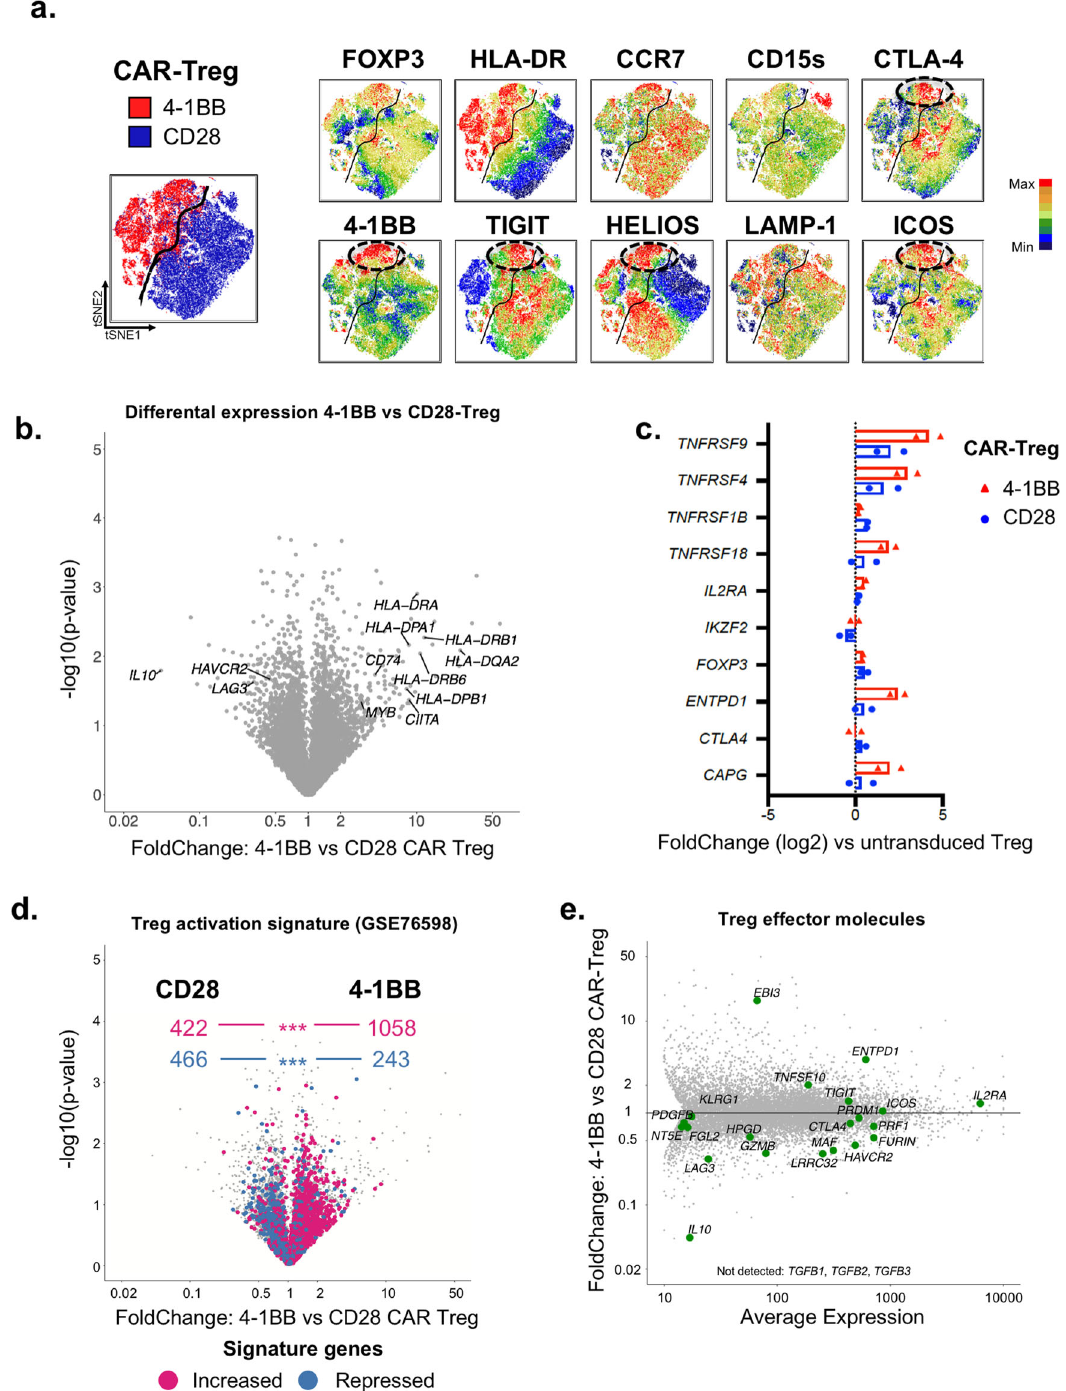
Fig. 3 4-1BB and CD28 tonic signaling induces different Treg differentiation pathways. a tSNE maps of CD28 and 4-1BB CAR-Tregs on day 16 are shown. Each point in the tSNE maps represents an individual cell, and cells are colored according to the intensity of fl uorescence of the indicated markers. n = 3 donors pooled from three independent experiments. b – e All of the transcriptomic data come from two independent experiments in which living untransduced Tregs (UT), 4-1BB CAR-Tregs and CD28 CAR-Tregs were FACS-sorted on day 16 of culture. b Volcano plot (Fold-Change [FC] vs. − log 10 ( p -value)) displaying the transcriptomes of 4-1BB CAR-Tregs vs. CD28 CAR-Tregs. c Bar graph showing the expression of the human core Treg genes from Zemmour et al., 2018 41 for each CAR-Treg population (blue bars = CD28, red bars = 4-1BB), in comparison with untransduced Tregs. d A Treg activation gene signature from 69 is mapped on the 4-1BB vs. CD28 volcano plot (same as b .). Values in the top half represent the number of genes, either upregulated (purple) or downregulated (blue) in the Treg activation signature, according to their enrichment in 4-1BB vs. CD28 CAR-Tregs. p -values for the signature enrichment were obtained by χ 2 test. *** p < 0.0001. e MvA plot showing the average expression of the key genes involved in Treg effector function according to their differential expression between 4-1BB and